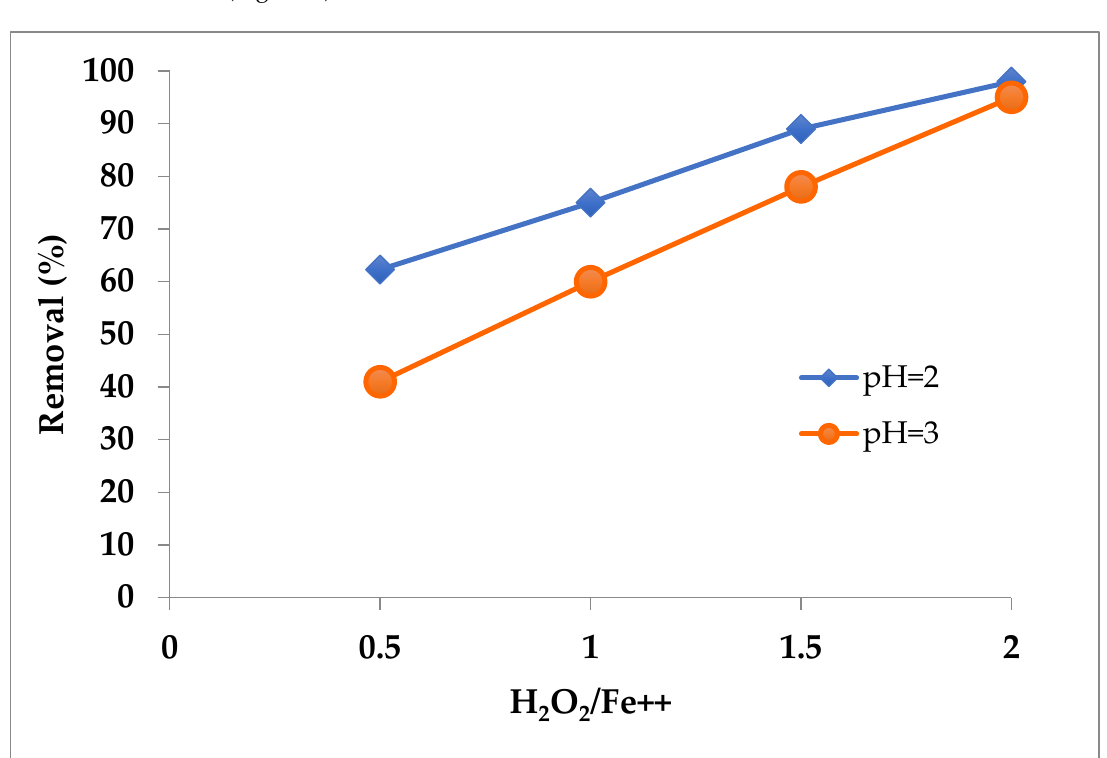
Figure 8. Effect of pH and Fe 2+ concentration on the organic matter removal. T = 25 °C t = 30 min. Mean values (n = 3).